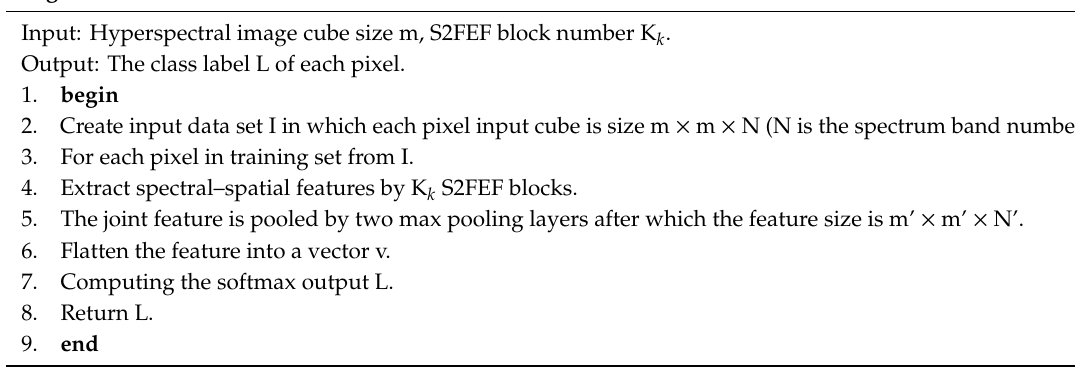
Algorithm 2: S2FEF-CNN